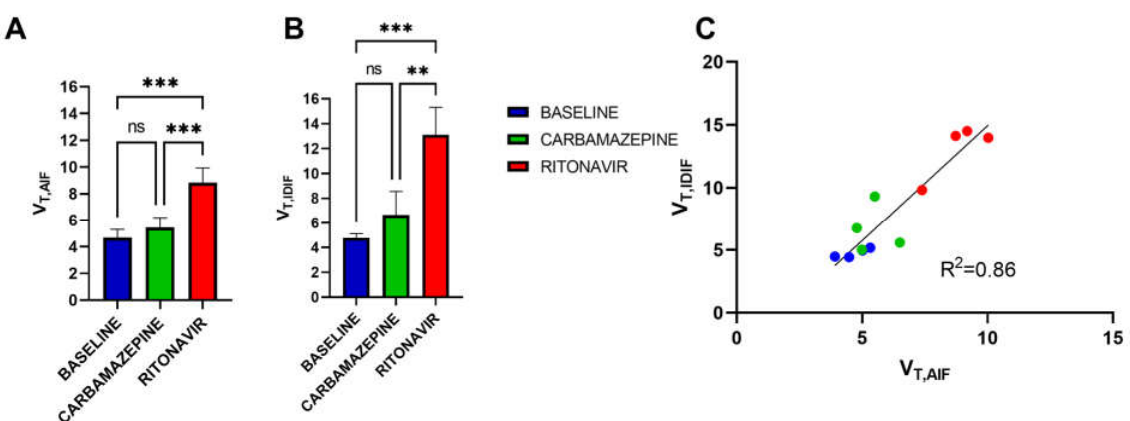
Figure 5. Brain volume of distribution ( V T ) of [ 11 C]metoclopramide in groups without (baseline) and with pretreatment with carbamazepine or ritonavir determined with the arterial input function ( V T,AIF , ( A ) or the image-derived input function ( V T,IDIF , ( B ) and linear correlation between V T,IDIF and V T,AIF (C). Data are reported as mean ± S.D with n = 3 (AIF) or n = 4 (IDIF) per condition. *** p < 0.001, ** p < 0.01, ns = not significant (two-way ANOVA with Tukey’s post hoc test for multiple compari- son).